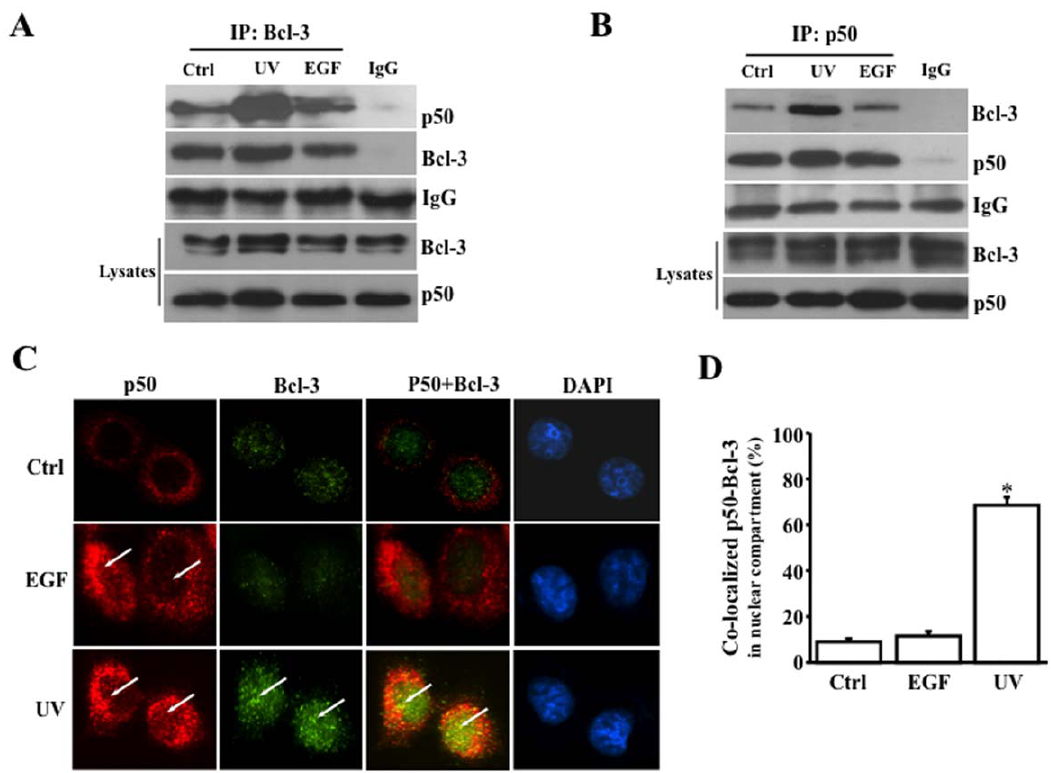
Figure 5. UV stress-induced activation and interaction of Bcl-3 and p50. (A) Immuno-coprecipitation of Bcl-3 and p50 pulled down by anti- Bcl-3 antibodies. (B) Immuno-coprecipitation of Bcl-3 and p50 pulled down by anti-p50 antibodies. (C) Nuclear immuno-colocalization of Bcl-3 and p50 in UV stress-induced HCE cells. Arrows indicate activated p50, Bcl-3 and p50 + Bcl-3 localized in the nucleus. (D) Statistical significance of immuno- colocalized nuclear Bcl-3 and p50 in UV stress-induced HCE cells. Bcl-3 and p50 in control, EGF stimulated and UV stress-induced HCE cells were detected by immunostaining experiments with specific antibodies against Bcl-3 and p50. Cell nuclei were detected by DAPI staining. Arrows are indicating immune activities that by were imaged by using a Nikon fluorescent microscope at 40 6 , and data were analyzed by Nikon software. Symbol ‘‘*’’ indicates significant differences ( p , 0.05, n=26).